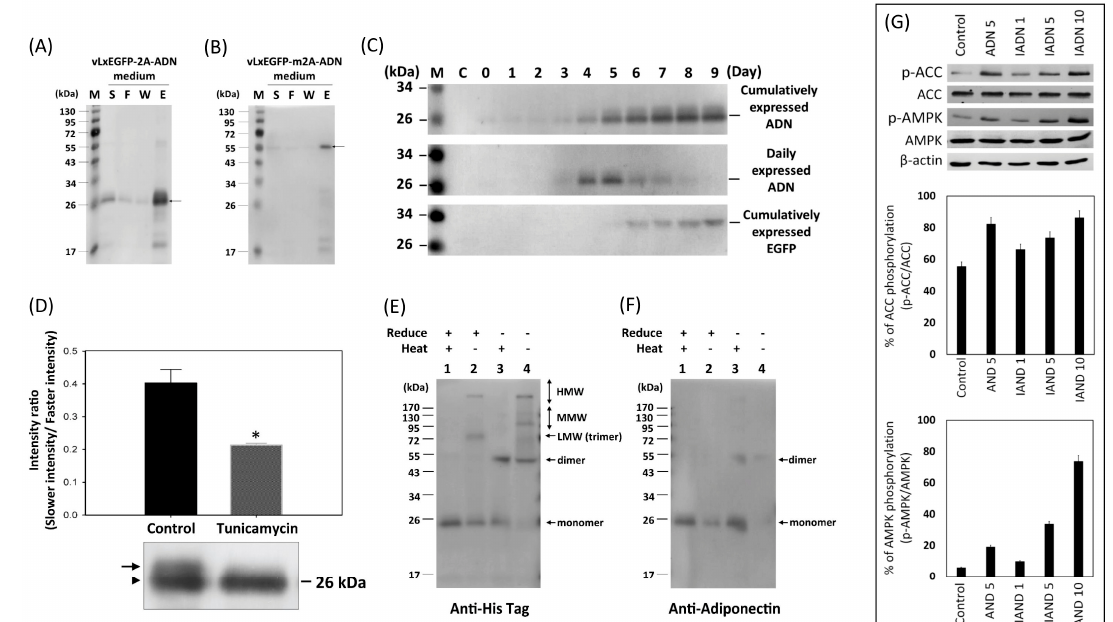
Figure 5. Demonstration of porcine adiponectin (ADN) and EGFP expression by EGFP-2A-based expression system. ( A – C ) Purification of recombinant proteins from culture medium. The medium obtained from NTU-LY cultures infected with the recombinant virus vLxEGFP-2A-ADN (A) or vLxEGFP-m2A-ADN ( B ). The major bands representing the purified recombinant proteins in elution fractions are indicated by arrows. ( C ) Time-course of protein expression in the culture medium. S = supernatant; F = sample from fraction; W = sample from washed solution; E = eluted sample; C = medium collected from uninfected cultures for the negative control; M = protein marker; * = significant difference. ( D ) Glycosylation of recombinant proteins in culture medium. Arrow indicates glycosylated band (slower migrating band), and arrow head indicates non-glycosylated band (faster band). Glycosylated band was decreased more than non-glycosylated band by tunicamycin treatment. ( E , F ) Multimer separation patterns of ADN expressed in NTU-LY cells by SDS-PAGE under various conditions. Each lane was denoted with “+” (including reducing reagents in sample buffer or heat treatment) or “-” (not including reducing reagents in sample buffer or not heat treatment). HMW= high molecular weight; MMW = middle molecular weight; LMW = low molecular